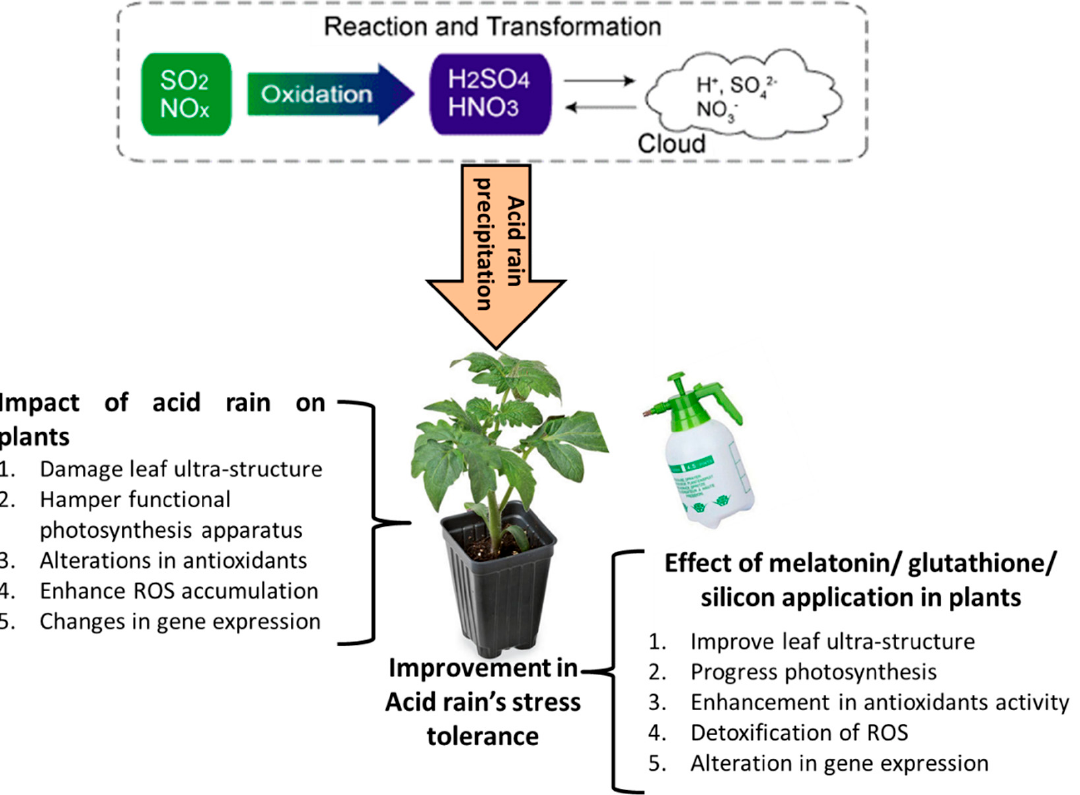
Figure 4. The role of melatonin, glutathione and silicon in mitigating the acid rain effects in plants.